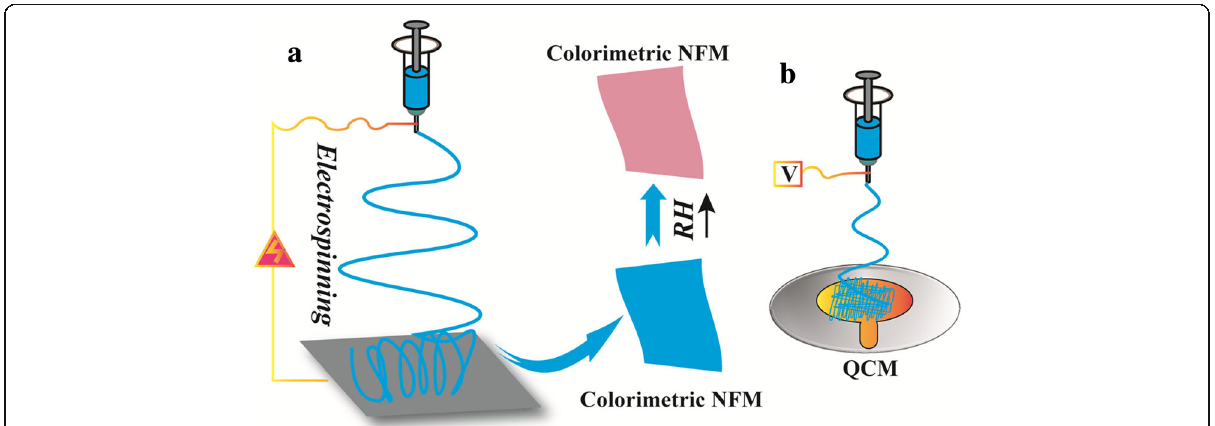
Fig. 1 Schematic illustrations of the electrospinning process to fabricate hybrid PA66/cobalt chloride NFM. a Fabrications of colorimetric NFM for humidity detection. b Illustration of depositing NFMs on the electrode surface of the